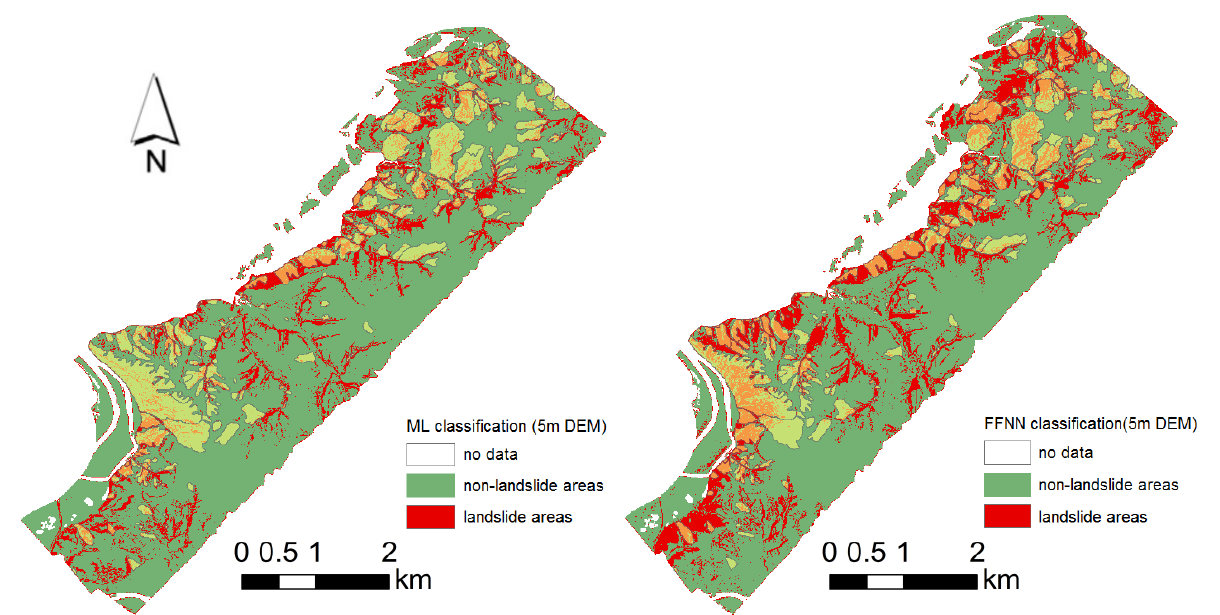
Figure 6 Examples of classification results for 5m resolution of